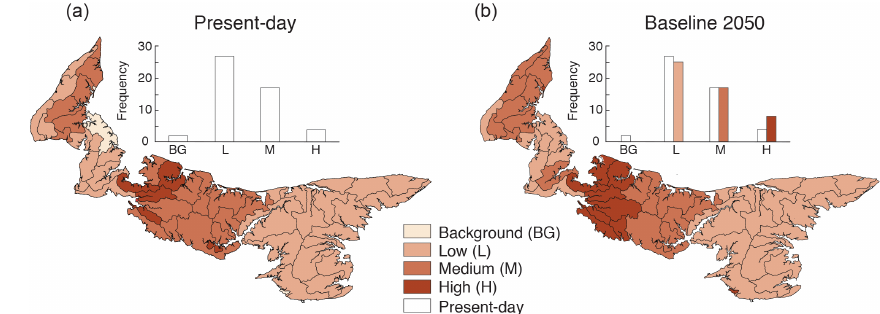
Figure 6. Class distribution of simulated mean nitrate concentration per watershed and histogram of the number of watersheds in each class for: (a) present-day (2001); (b) 2050 baseline scenario with present-day (2001) nitrate loading and groundwater recharge.